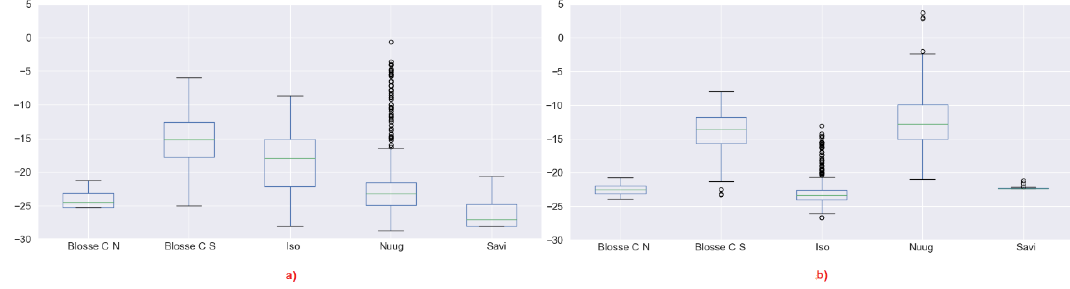
Figure 20. ( a ) Iceberg double bounce scattering boxplot 5 × 5 window, ( b ) 11 × 11 window. There are significant changes in Blosseville Coast N, Isortoq and Savissivik.